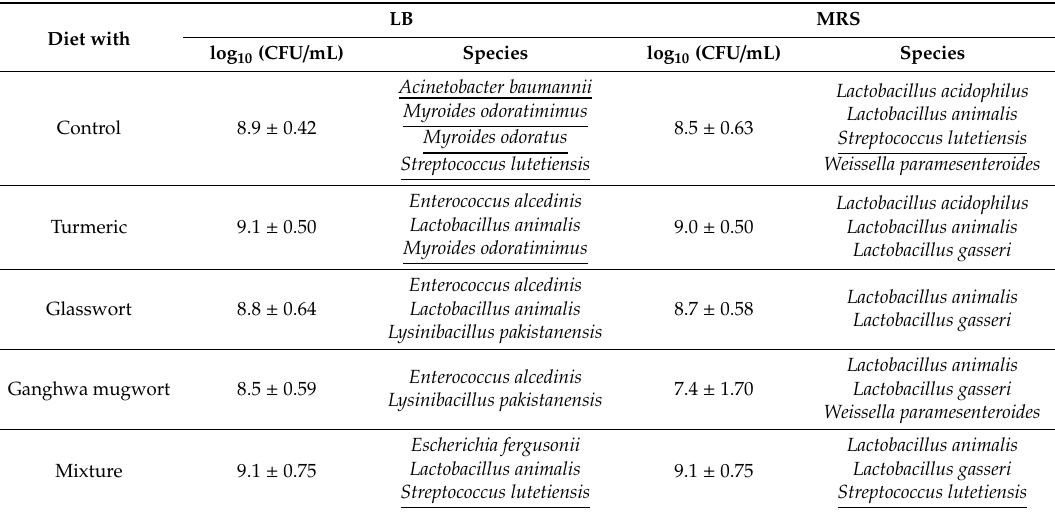
Table 5. Bacterial cell counts of beagle